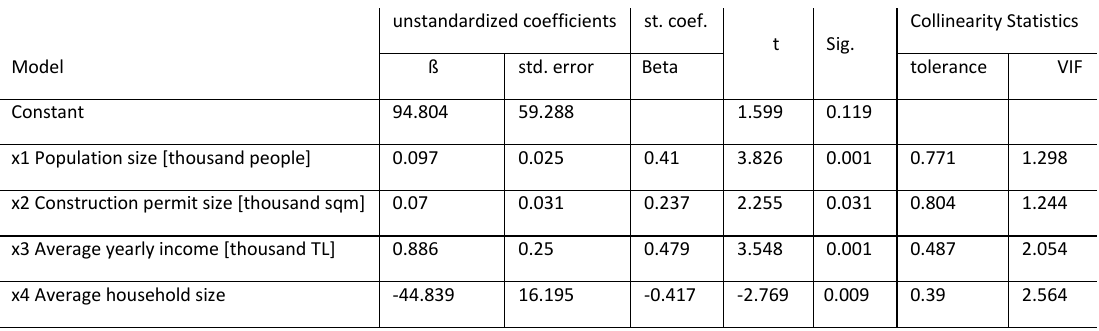
x3 Average yearly income [thousand TL] 0.886 x4 Average household size -44.839 Dependent variable is number of construction firms in